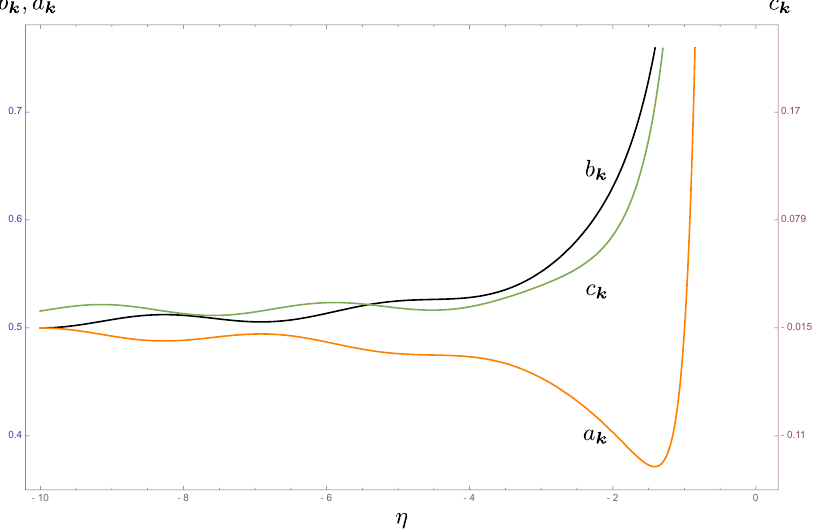
Figure 5. The time variation of the covariance matrix elements for mode k . The blue solid curve (cid:104) (cid:8) ˆ χ ( η ) , ˆ χ † ( η ) (cid:9) (cid:105) , the orange dashed curve a denotes b k = 1 k k 2 (cid:104) (cid:8) ˆ χ ( η ) , ˆ p ( η ) (cid:9) (cid:105) . We choose the parameter η dotted curve c k = 1 k k 2 behaviors are qualitatively different, when | k η | < 1, where the corresponding mode has a physical wavelength greater than the Hubble